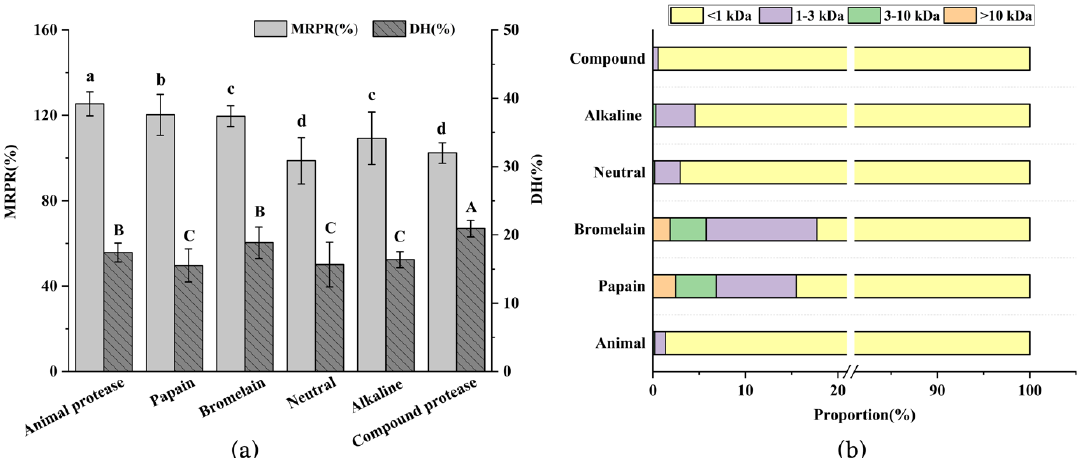
Figure 1. Relative proliferation rate of macrophages (MRPR) and degree of hydrolysis (DH) with different enzymatic hydrolysis products ( a ), and molecular weight distribution of different enzymatic hydrolysates ( b ). Different uppercase letters in the figure indicate significant differences in DH ( p < 0.05); different lowercase letters indicate significant differences in MRPR ( p < 0.05).